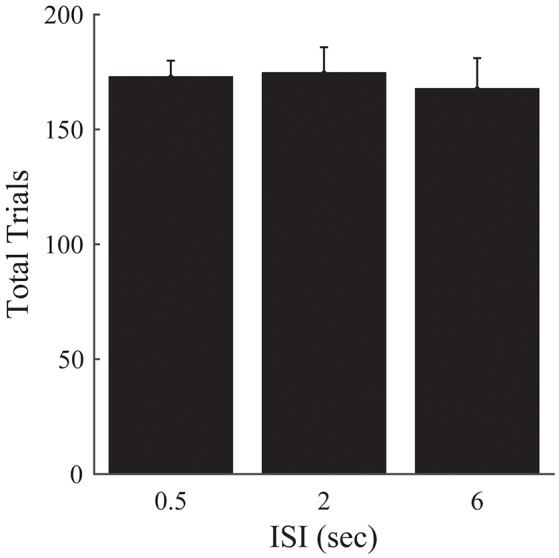
Experiment 2B. Total trials completed over all episodes as a function of ISI. Error bars represent ±1 SEM. There are no significant differences between the different ISI conditions. Since the other analyses presented in Figure 5 are robust to differences in the amount of time provided to perform the task, we omit them here.